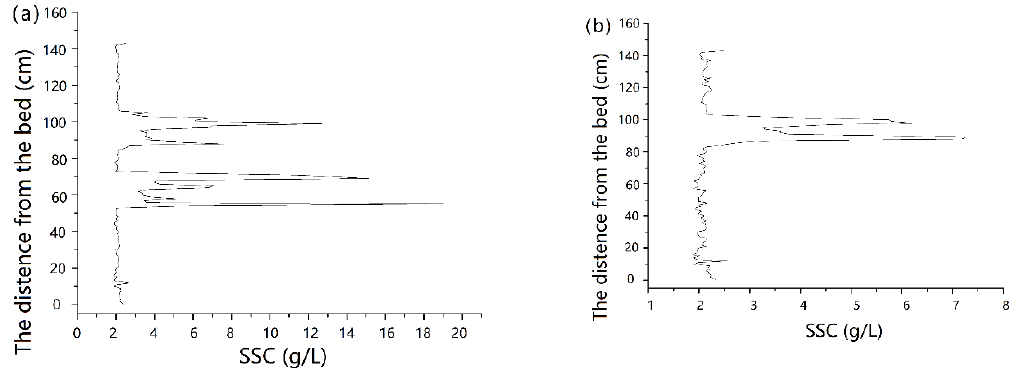
Figure 13. ( a ) The two lutoclines at 07:00 on 30 December 2016, when the maximum SSC exceeds 18 g/L; ( b ) a single lutocline at 10:30 on 1 January 2017.